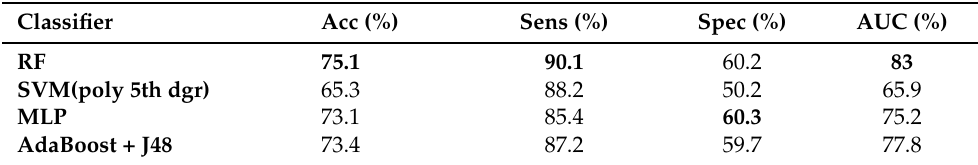
Table 7. The values of the classification performance parameters for texture analysis methods combined with conventional classifiers, obtained on B-mode ultrasound images.